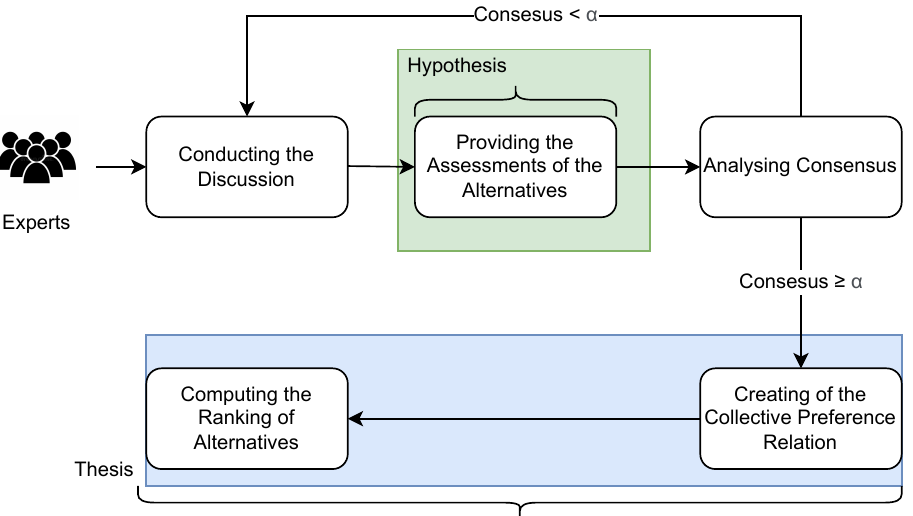
Figure 2. Sections affected by the hypothesis and thesis within the basic outline of a GDM